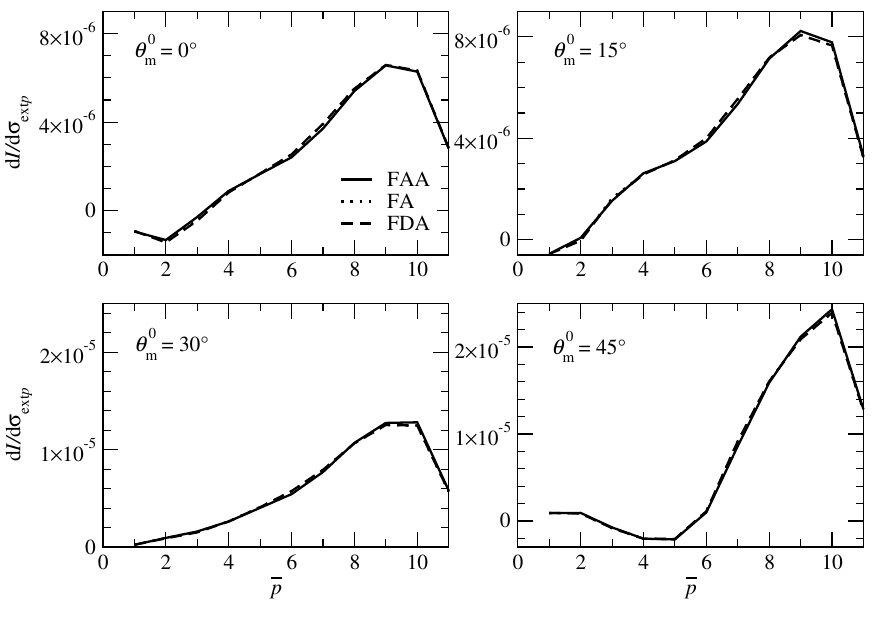
y = y 0 z = p ∆ z ), p = 1,...,11, t , t ,